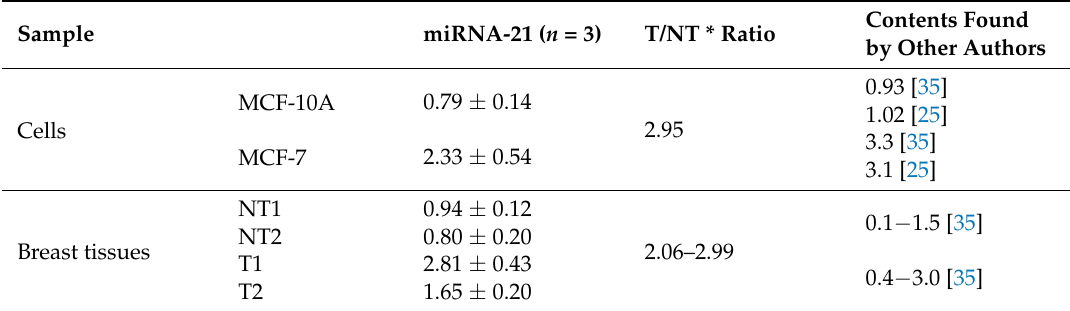
Table 5. Determination of the endogenous content of miRNA-21 (in amol per ng of RNA t ) in human cells and breast